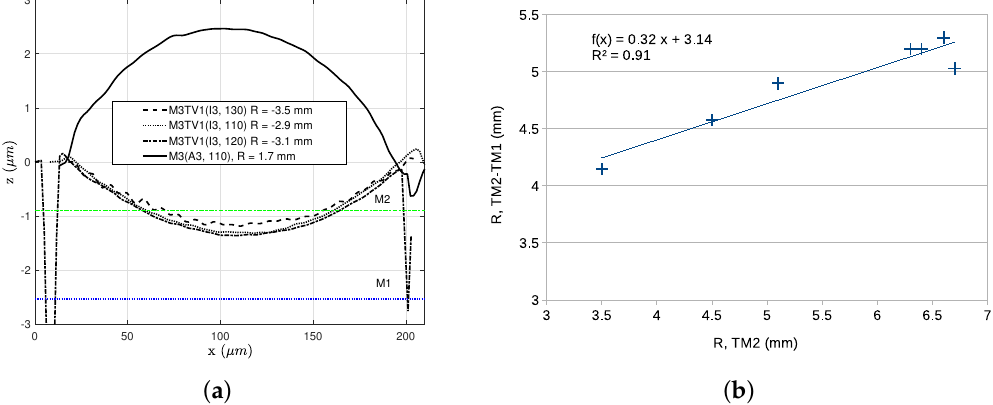
Figure 10. Profile and radius of curvature comparison for three different M3 —TVia1 membranes and one M3 membrane ( a ). Radius of curvature correlation for TM1-TM2(P) and standalone TM2(N4) plates obtained from seven chips ( b